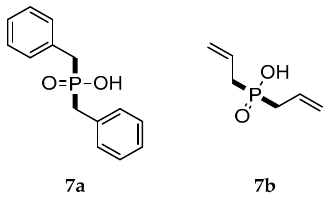
Figure 5. Chemical structure of 7a and 7b .